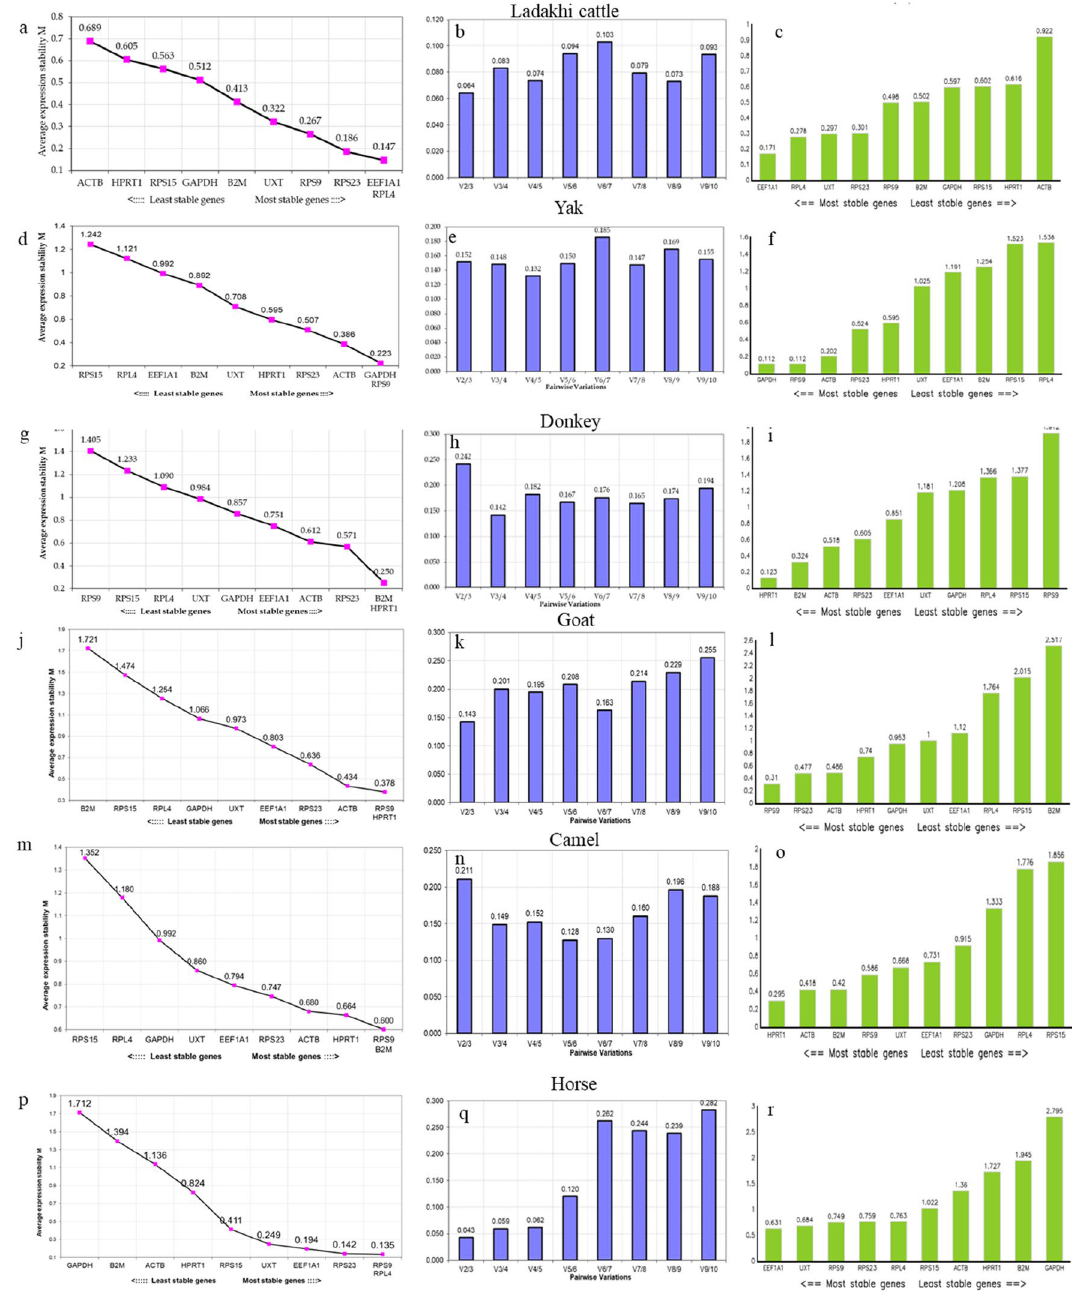
Figure 2. geNorm analysis for ranking of genes based on average expression stability measure (M value), Pair-wise variation (Vn/Vn + 1) between the normalization factors NFn and NFn + 1 to determine the optimal number of reference genes and Normfinder analysis in LAC ( a – c ), LAY ( d – f ), LAD ( g – i ), CHG ( j – l ), DHC ( m – o ) and ZAP ( p – r